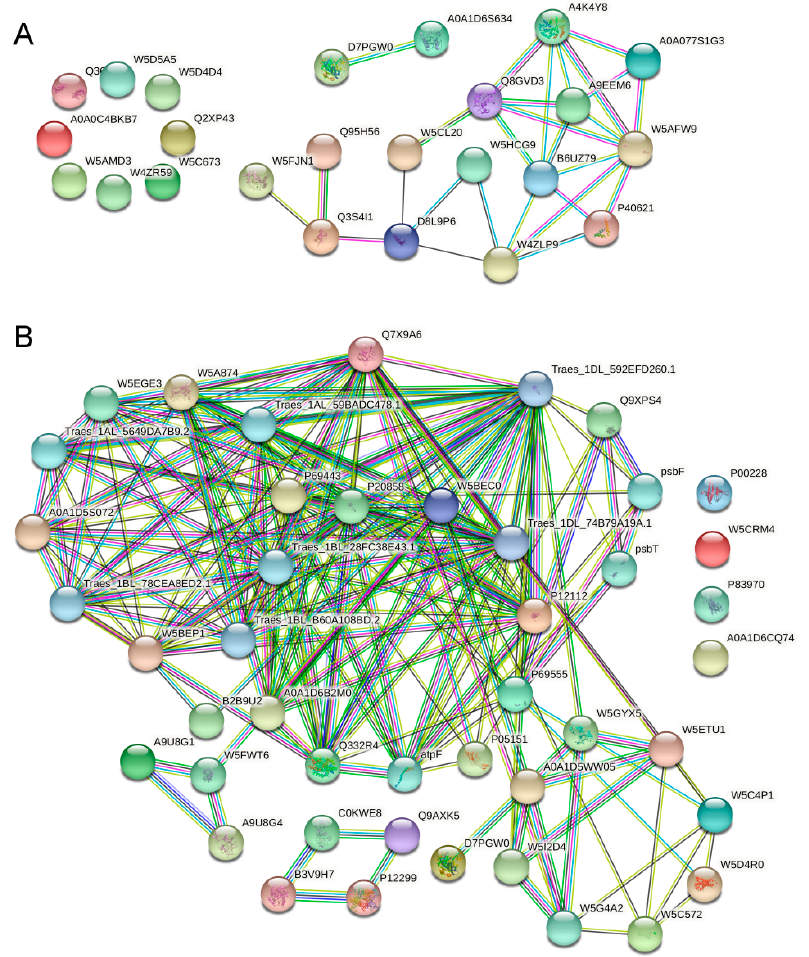
Figure 10. Protein–protein interaction network for DEPs. ( A ) P2 vs. Y2. ( B ) P4 vs. Y4 (which is involved in energy metabolism and carbohydrate metabolism). The network was constructed using the String program (the STRING resource was available online at http://www.string-db.org/) with a confidence score higher than 0.4. Nodes represent proteins, and the line thickness represents the strength of the supporting data.